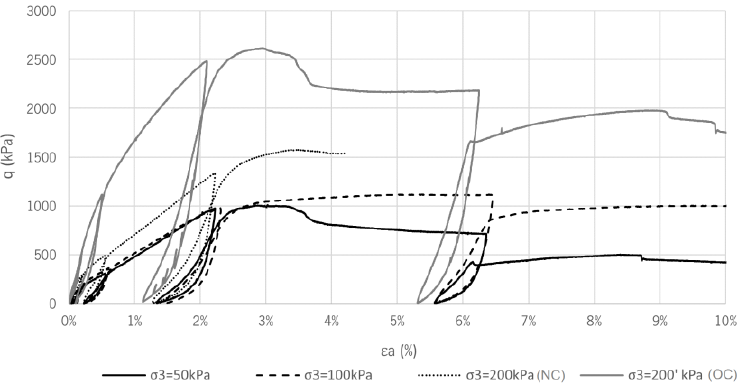
Figure 19. Evolution of the deviator stress with axial strain (stabilized specimens).